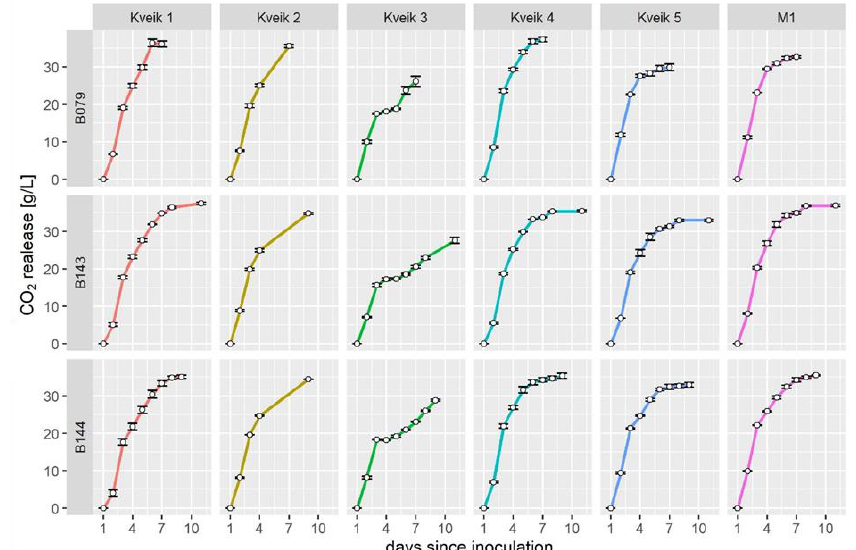
Figure 3. Co-fermentation of Kveiks with NCYs using granmalt wort at 20 °C. The five Kveiks were co-fermented with H. uvarum (B079, top row)), P. kudriavzevii (B143, middle row) and M. guilliermondii (B144, bottom row) at a ratio of 5:1. Mass losses were determined daily by weighing the tall tube fermenters. White circles mark the mean value of three replicate fermentations; error bars are the standard error of the mean. Table 5. Ethanol content (%) the end of Kveik + NCY